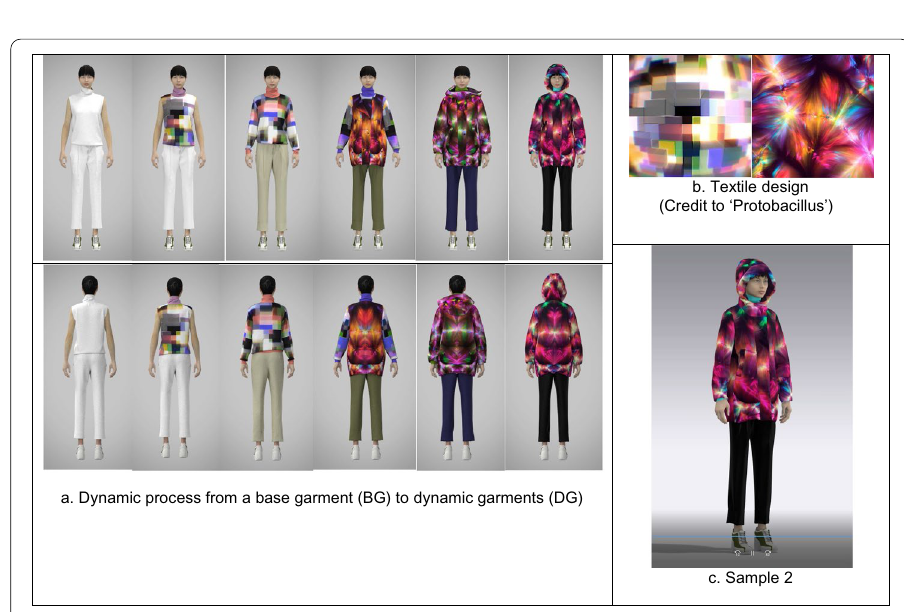
Fig. 2 The technical process to develop a 3D dynamic fashion garment (sample 2): a The moving images, b textile design (GIF), and c sample 2 (MP4) are available in Additional file